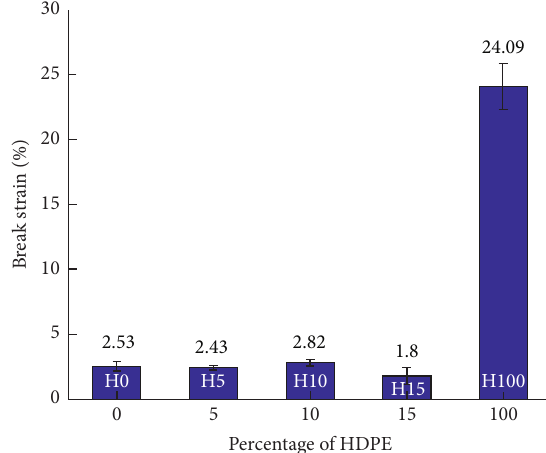
Figure 10: Effect of HDPE percentage on the break-strain